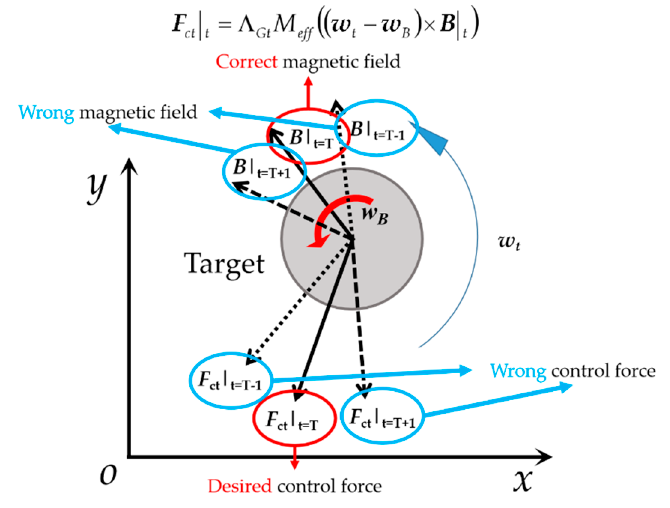
Figure 6. Diagram of instantaneous eddy current force.